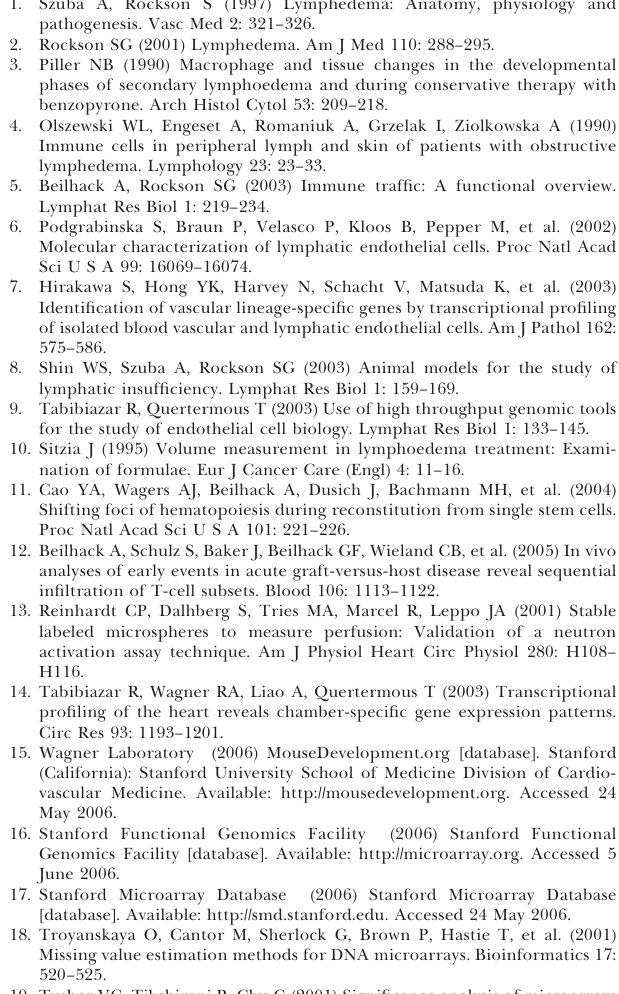
Table S1. Annotated List of the cDNAs Included on the Mouse Transcriptome Microarray Utilized in These Investigations Found at DOI: 10.1371/journal.pmed.0030254.st001 (75.6 MB